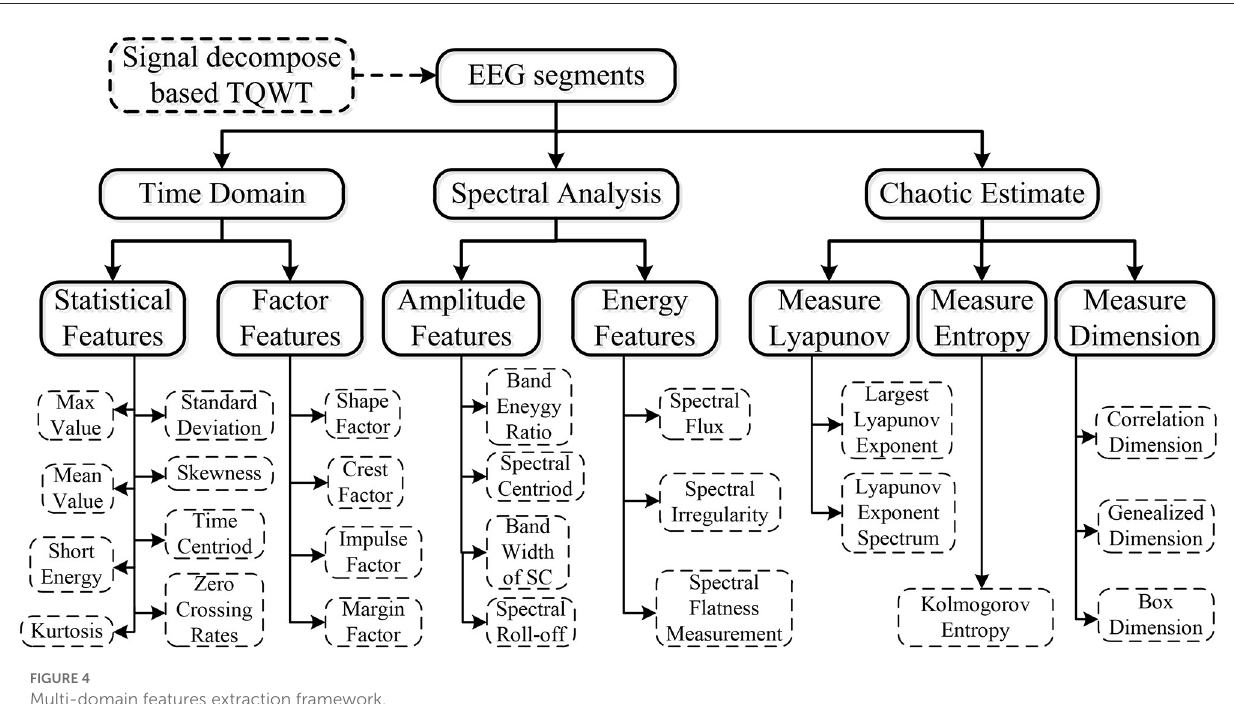
FIGURE4 Multi-domain features extraction